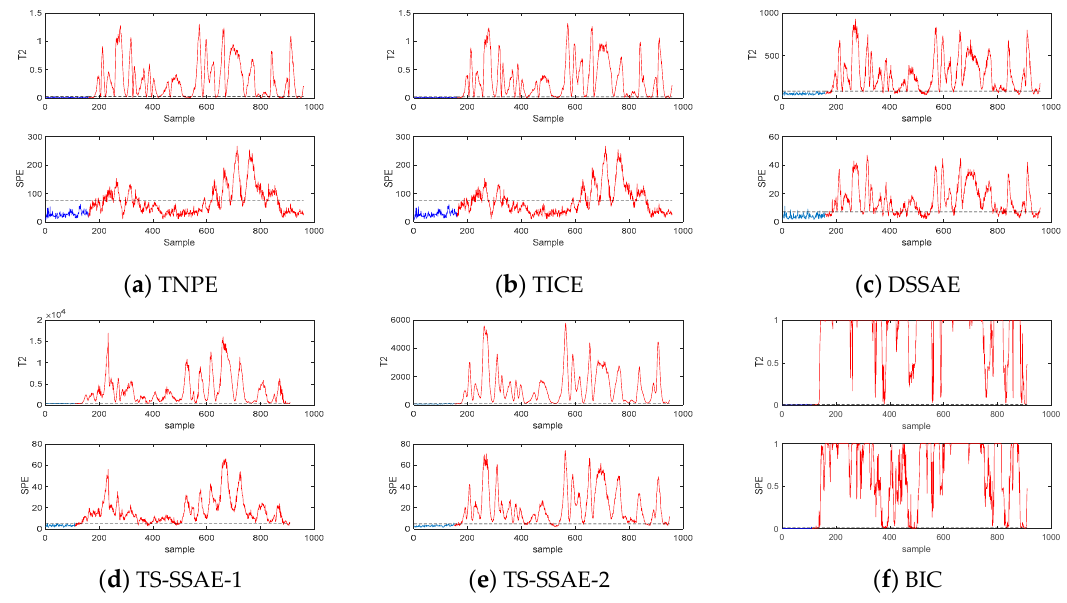
Figure 8. Monitoring results of the Tennessee-Eastman process for fault 10.